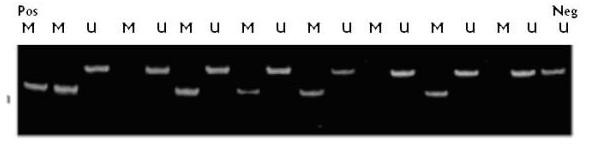
An ethidium bromide-stained 4% agarose gel for Rb gene methylation lane 1: methylated control, lane 18: unmethylted control, lanes 8–12: cases of invasive squamous cell carcinoma, lanes 12–17: CIN cases.